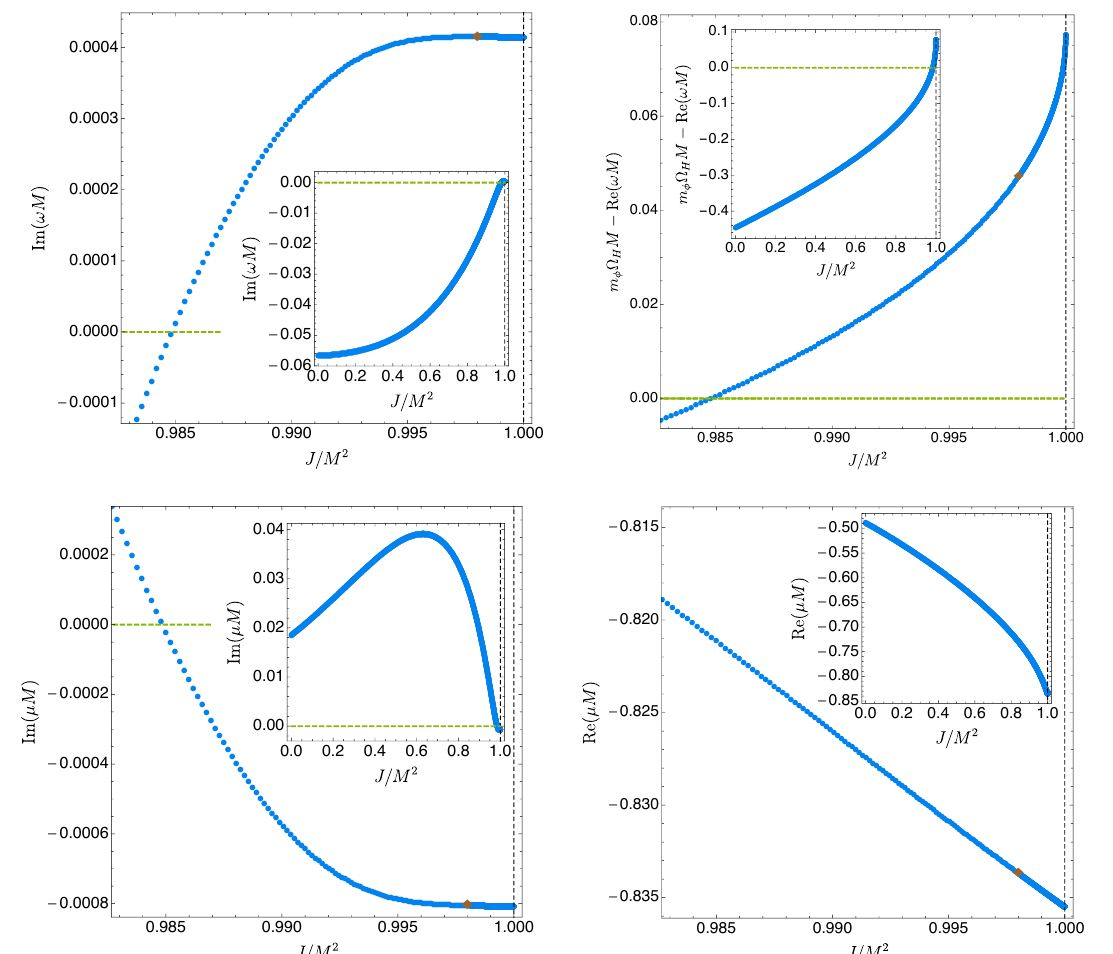
Figure 2 . Kerr black hole: e(cid:11)ect of black hole rotation. Unstable Proca modes with dimensionless mass mM = 0 : 51 ( m (cid:30) = 1) as a function of the dimensionless angular momentum J=M 2 = a=M of the Kerr black hole. The upper panels describe the imaginary and real part of the dimensionless frequency !M , while the lower panels give the imaginary and real parts of the dimensionless angular eigenvalue (cid:22)M . Both Im( !M ) and Re( m (cid:30) (cid:10) H (cid:0) ! ) M change sign at J=M 2 (cid:24) 0 : 98483373627 and the main plots show the region that extends from the neighbourhood of this transition all the way to extremality at J=M 2 = 1 (the inset plots show all the range 0 (cid:20) J=M 2 (cid:20) 1). The maximum of Im( !M ) is attained for J=M 2 (cid:24) 0 : 9976975410. The brown diamond signals the solution with rotation J=M 2 = 0 : 998 that will be analyzed in the Kerr-Newman and Kerr-Sen backgrounds, namely in (cid:12)gure 3 (this is the same solution that was pinpointed in (cid:12)gure 1 also with a brown